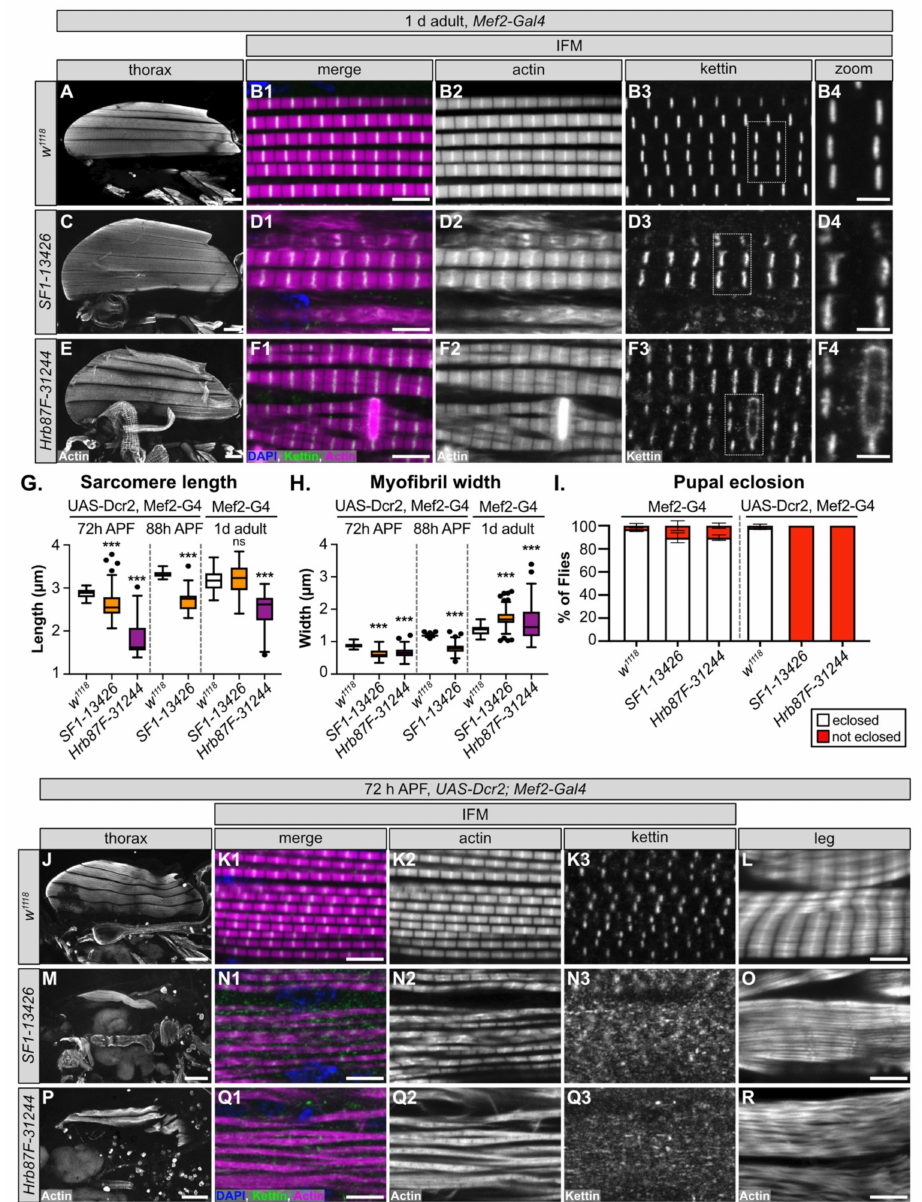
Figure 6. SF1 and Hrb87F are required for proper myofibril development and Z-disc stability. ( A – F ) Confocal Z-projection images, table 1. d adults after Mef2-Gal4 driven knockdown of SF1 ( C – D ) and Hrb87F ( E – F ). Although gross myofiber structure is intact ( A , C , E ), compared to w 1118 controls ( A – B ), knockdown myofibrils are thick and split with short sarcomeres and actin-inclusions at the Z-discs ( B2 compared to D2 and F2 ). kettin staining at the Z-disc is discontinuous and less refined and is aberrant in the vicinity of zebra-bodies (compare B3,B4 to D3,D4 and F3,F4 ). Scale bars = 100 µ m ( A,C,E ), 5 µ m ( B1,D1,F1 ) and 2 µ m ( B4,D4,F4 ). ( G – H ) Quantification of sarcomere length ( G ) and myofibril width ( H ) after SF1 (orange) and Hrb87F (purple) knockdown at 72 h APF, 88 h APF or in 1 d adults. Significance is from post hoc Tukey’s test after ANOVA; ***, p < 0.001. (I) Plot of the percent of pupae with SF1 or Hrb87F knockdown that are able to eclose (white) or remain trapped in the pupal case (red). Genotypes as labeled. Error bars show standard deviation. ( J – R ) Confocal Z-projection ( J,L,M,O,P,R ) and single-plane images ( K,N,Q ) showing muscle phenotypes at 72 h APF with UAS-Dcr2, Mef2-Gal4 driven knockdown of SF1 ( M – O ) and Hrb87F ( P – R ). Enhanced knockdown efficiency results in degraded ( Q2 ) and split ( N2 ) myofibrils with short sarcomeres. Kettin localization at the Z-disc is impaired and Z-discs are poorly defined ( N1 – N3,Q1 – Q3 ). Sarcomere structure and organization in tubular leg muscles is also disrupted ( L compared to O and R ). Scale bars = 100 µ m ( J,M,P ), 5 µ m ( K1,L,N1,O,Q1,R